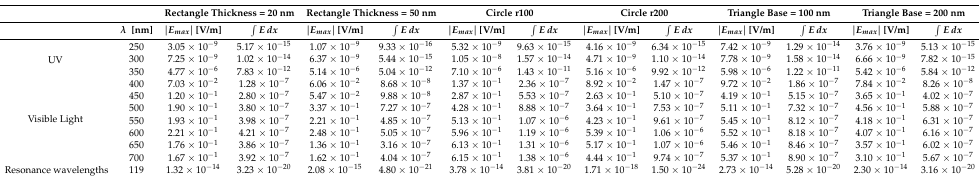
Table A5. Summary table of the results obtained for the aluminium nanostructures—Probe 2.